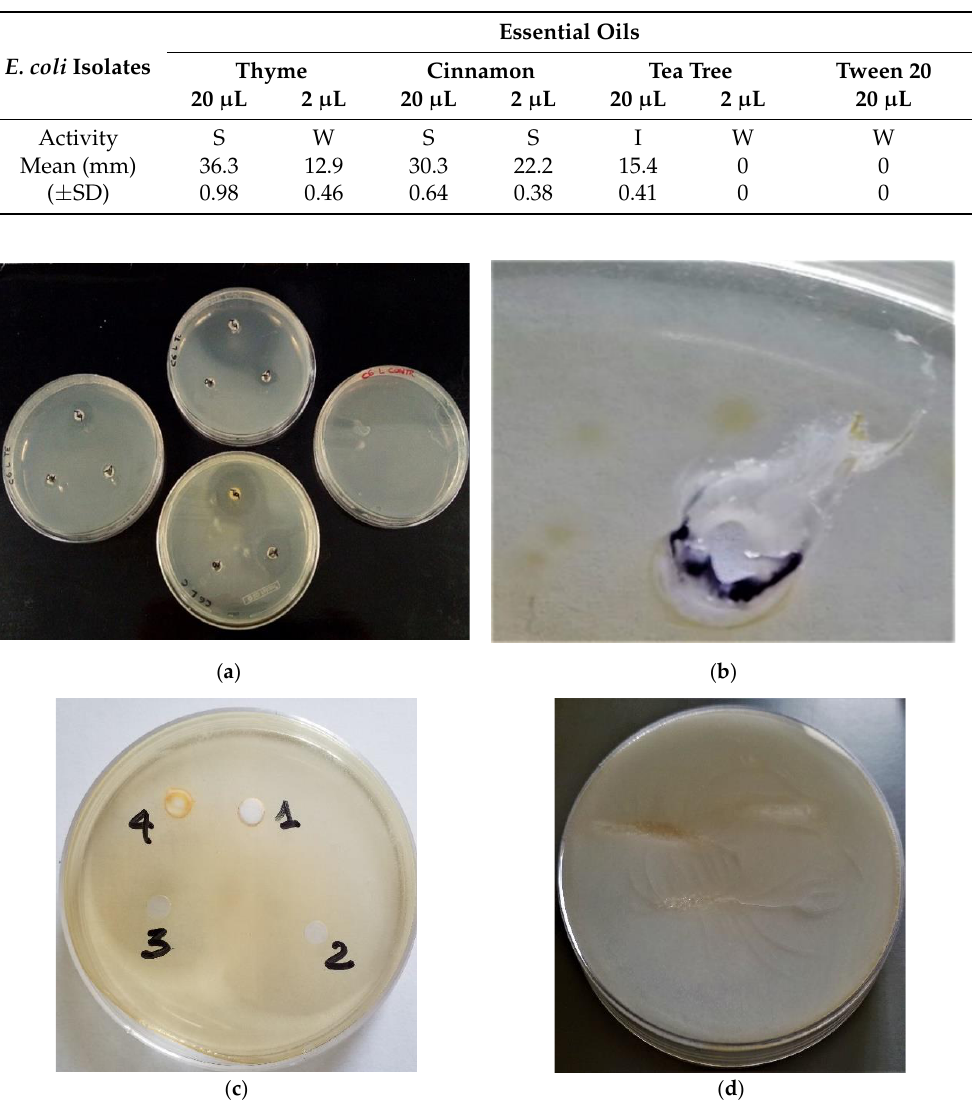
Table 7. Statistical significance among aromatograms of three EOs (thyme, cinnamon, tea tree) at two volumes (20 µL and 2 µL) vs. antibiotics for veterinarian and human use, respectively. Data interpretation in § 4.8.